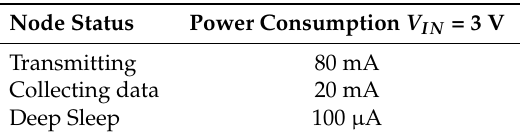
Table 1. Sensor node power